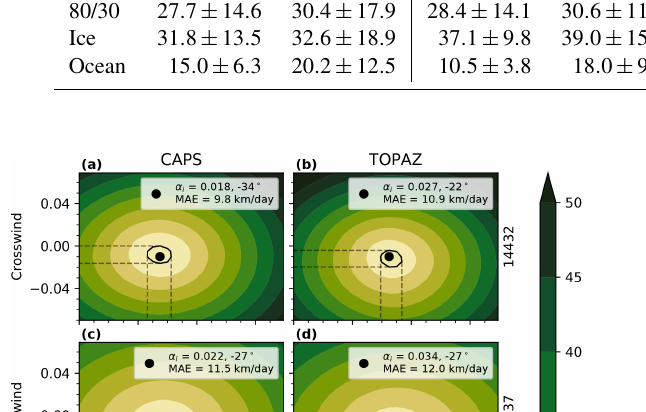
Table 3. Mean and standard deviation of separation distance d after 48h (in km) from Fig. 7 for each drifter, forcing, and drift model. Drift 14432 14437 14435 14438 Model CAPS TOPAZ CAPS